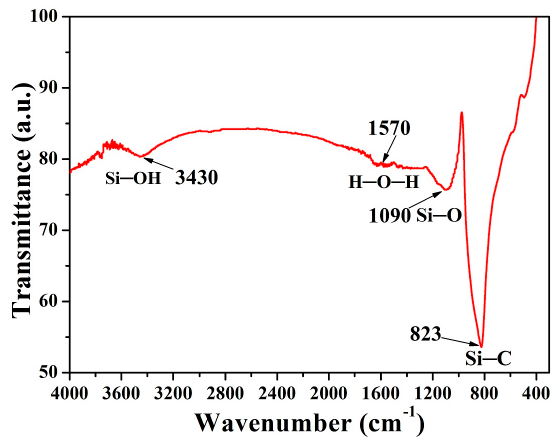
Figure 7. β -SiC FT-IR spectrum of A 8 .